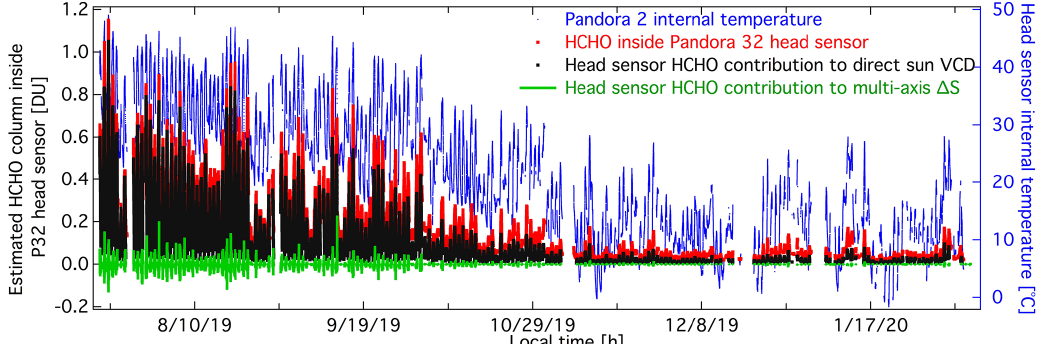
Figure 8. Estimated HCHO column density inside Pandora 32 head sensor during deployment at NASA-GSFC, Greenbelt, MD. Estimation is based on the exponential function amplitude derived from Pandora 32 and Pandora 2 direct-sun measurements of HCHO (0.0133DU) and exponential function damping coefficient derived from the laboratory measurements of four other instruments (0.091). Direct-sun air mass factors used to calculate HCHO are limited to solar zenith angles smaller than 80 ◦ .